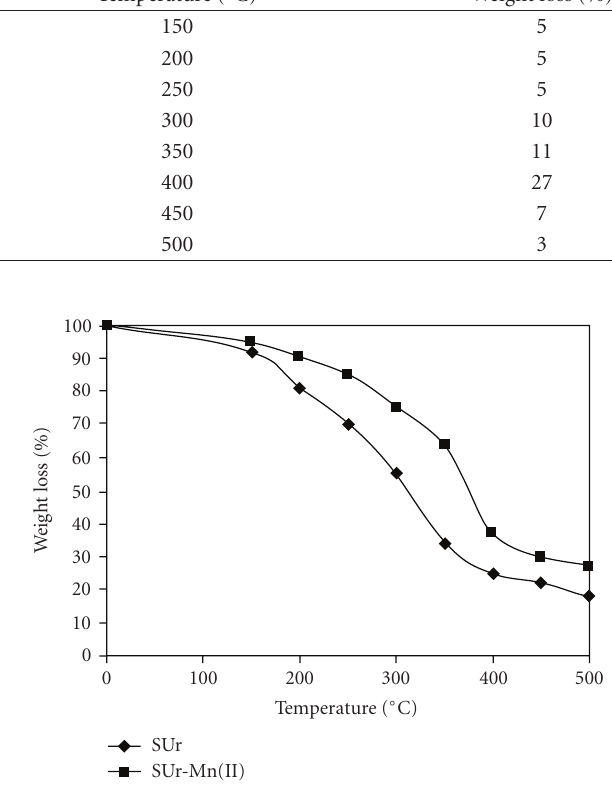
Figure 1: TGA curve of SUr and